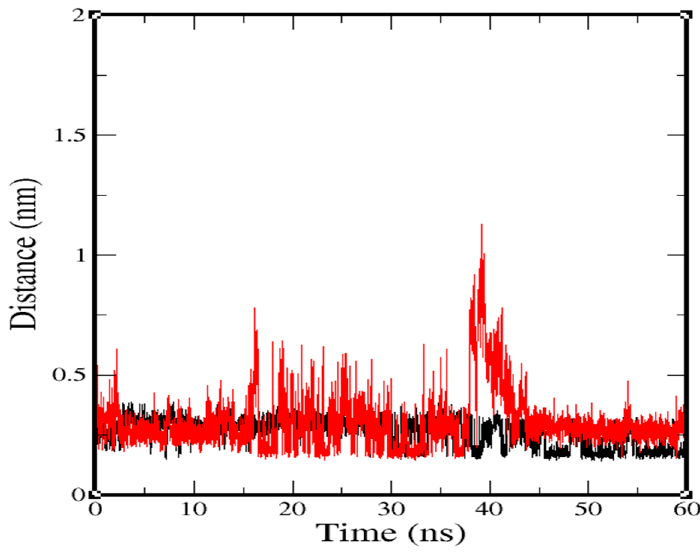
Figure 5. Calculation of minimal distances from ligand within 0.4 nm to close residues. Black, NuBBE-1970–NSP15; red, NuBBE-242–NSP15.